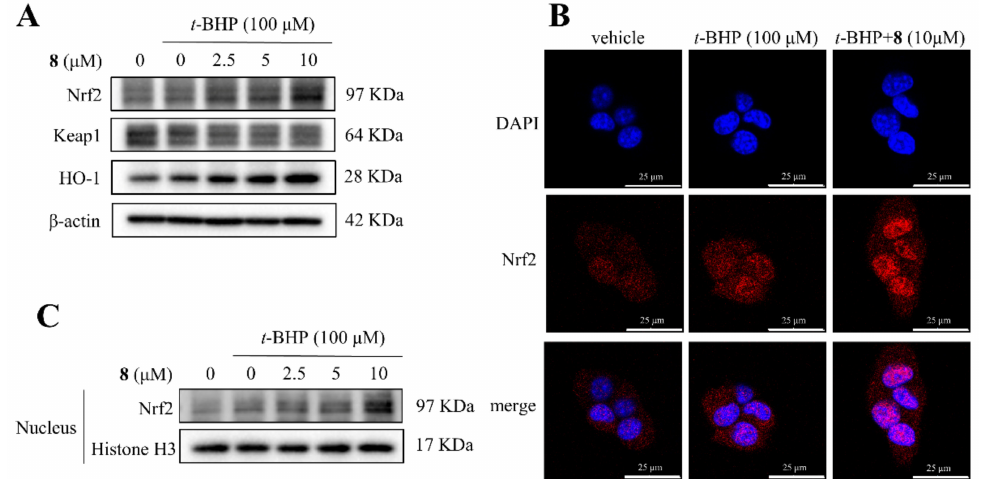
Figure 11. Compound 8 activates Keap-1/Nrf2/HO-1 signaling pathway in t -BHP-injured AML12 hepatocytes. ( A ) The total protein levels of Keap-1, Nrf2, and HO-1 were analyzed by Western